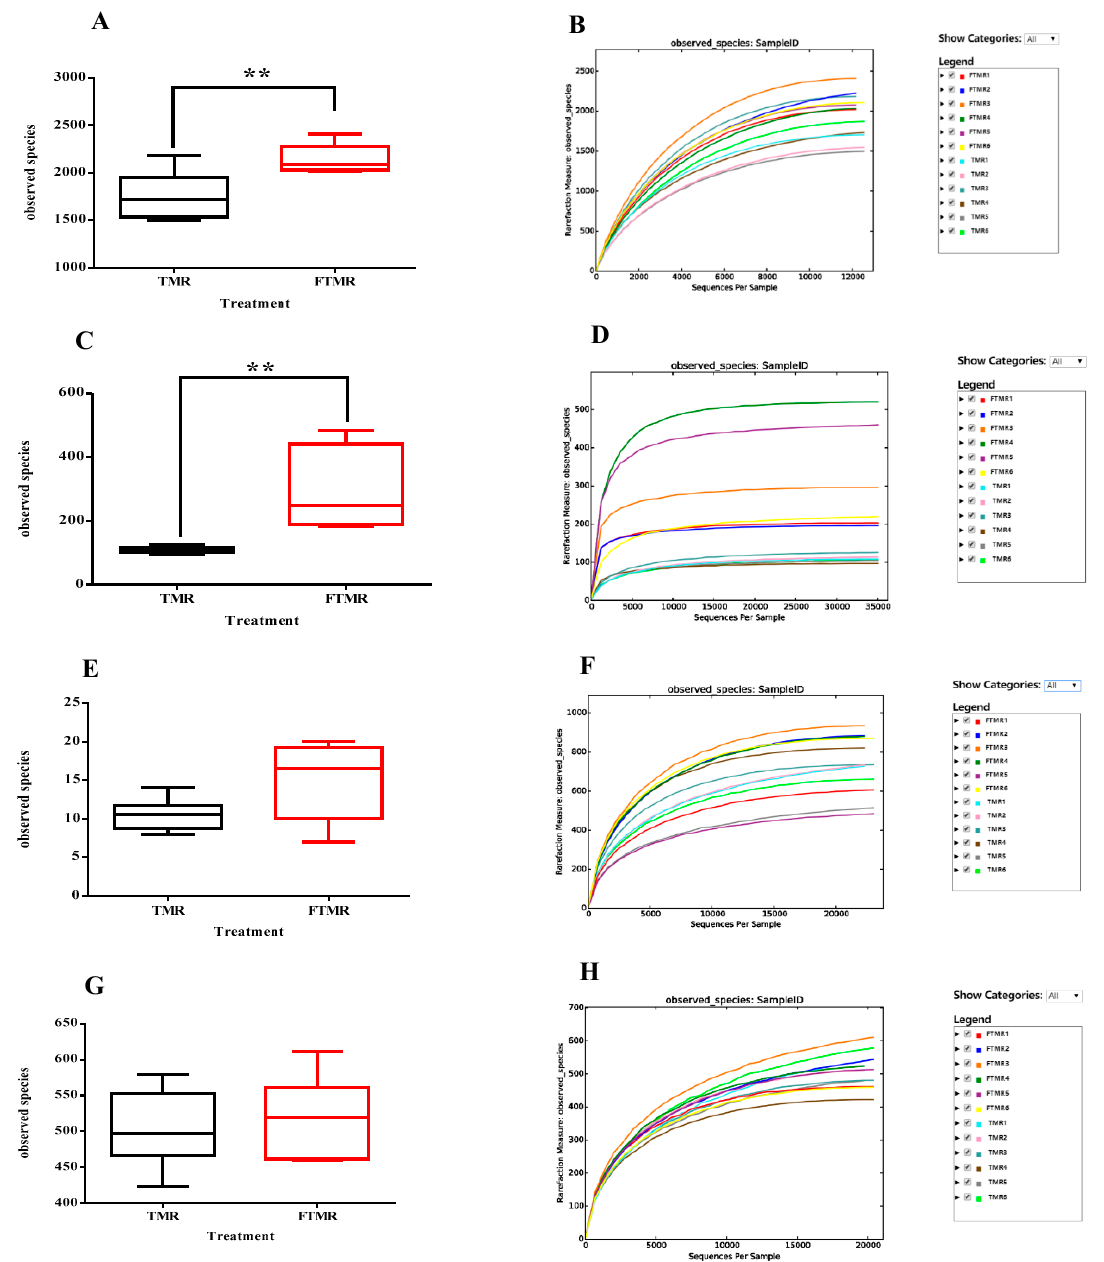
Figure 2. Boxplot and rarefaction curves of operational taxonomic units (OTUs). Bacterial ( A ), anaerobic fungi ( C ), protozoan ( E ), and archaea ( G ) boxplot represent the number of observed OTUs. The x -axis shows the observed species (OTUs), and the y -axis shows different groups (between TMR and FTMR). The OTU similarity threshold of 97% was considered. Boxes represent the interquartile range (IQR) between the first and third quartiles (25th and 75th percentile, respectively), and whiskers indicate the extremes of the data. * p < 0.05 and ** p < 0.01 (Student’s t-test). Bacterial ( B ), anaerobic fungi ( D ), protozoan ( F ), and archaea ( H ) rarefaction curves of OTUs. The x -axis shows the number of valid sequences per sample, and the y -axis shows the observed species (OTUs). Each curve in the graph indicates a different sample and is shown in a different color. The longer the curve, the higher the sequencing depth and the more OTUs are observed. The flatter the curve, the more the sequencing results reflect the diversity contained in the current sample. TMR, total mixed ration; FTMR, fermented total mixed ration.